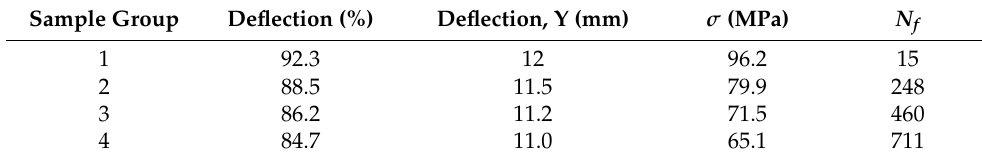
Table 5. Specimens tested in alternative bending.